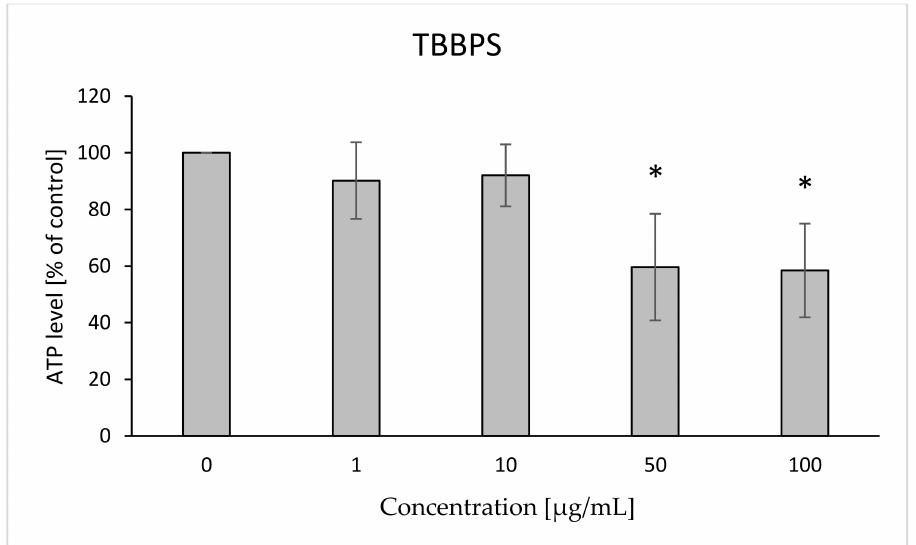
Figure 6. Changes in ATP level in human control erythrocytes and the erythrocytes incubated with TBBPS at 1 to 100 µ g/mL for 12 h. (*) Significantly different from control ( p <